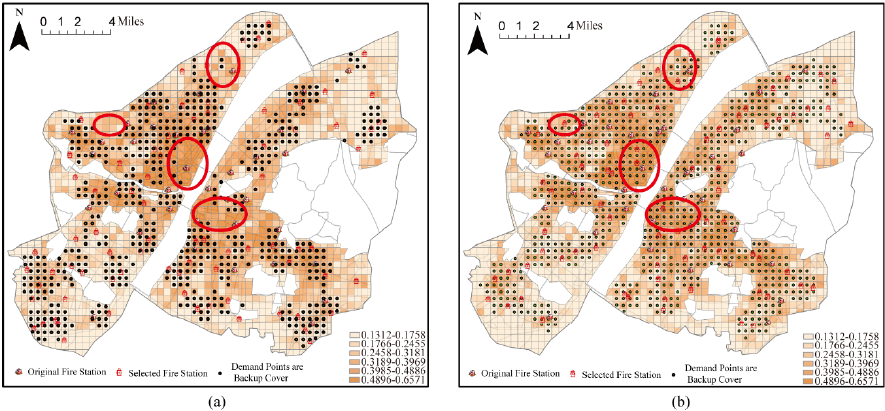
Figure 10. Coverage of fire stations considering existing stations. ( a ) Location optimization by the MCM; ( b ) location optimization by BCM.